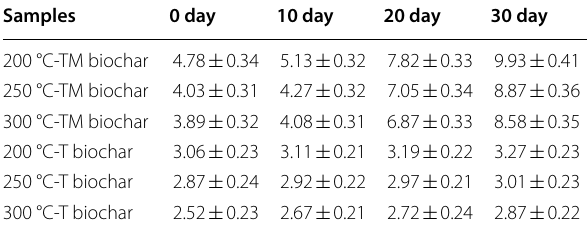
Table 3 Equilibrium moisture content (%) of microalgal biochar